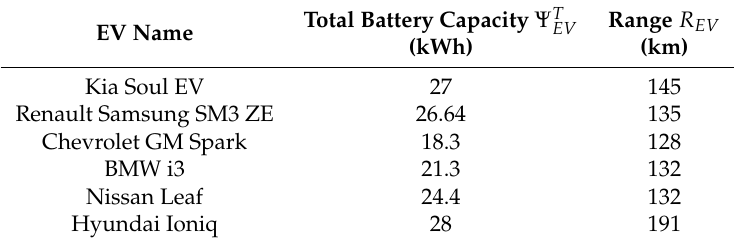
Table 1. Specifications of private EVs in Korea.